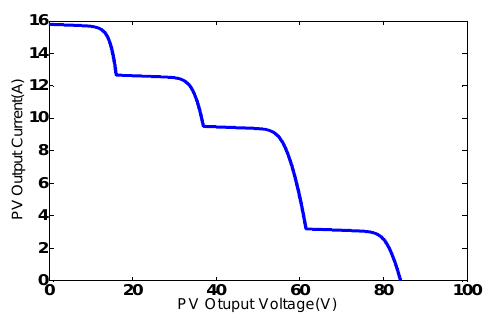
Figure 5. I-V curves in several shading conditions.